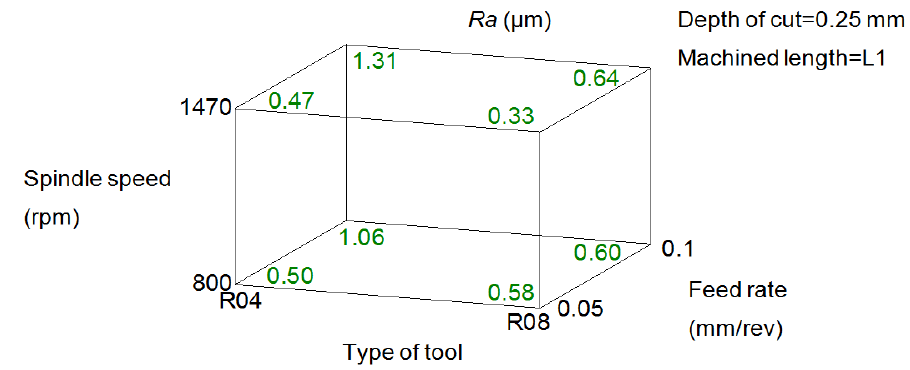
Figure 7. Cube plot of Ra versus the feed rate, spindle speed and type of